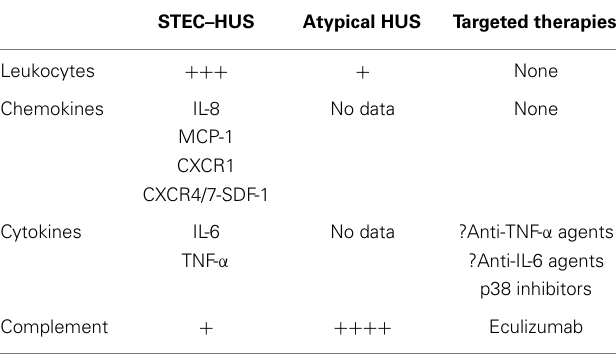
Table 2 | Inflammatory mediators in HUS